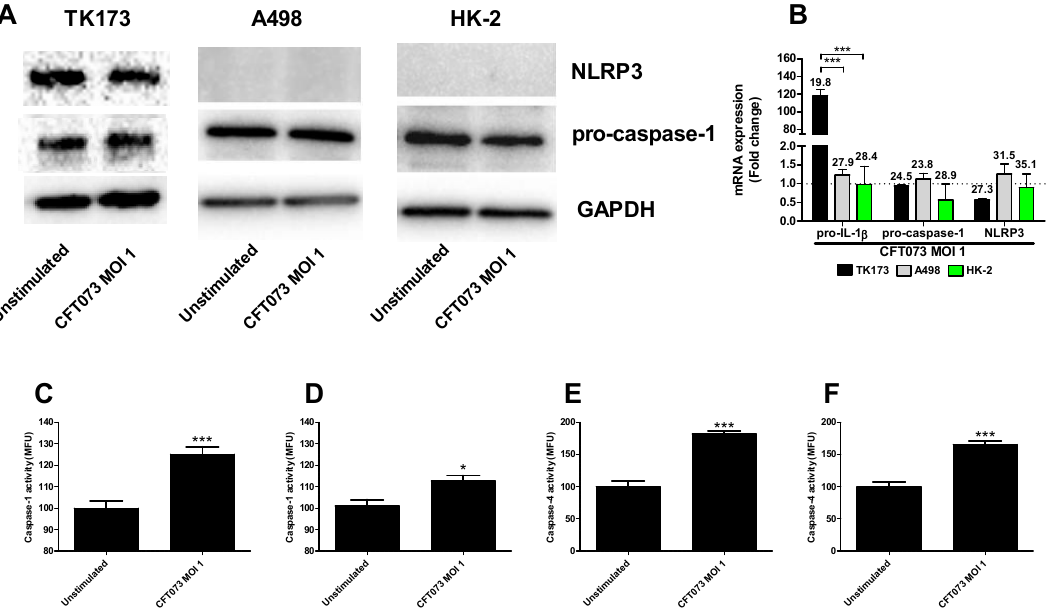
Figure 2. Caspase-1 and caspase-4 activity and pro-IL-1 β , pro-caspase-1 and NLRP3 expression. Renal fibroblasts ( A – F ) and renal epithelial cells ( A , B ) were infected with UPEC strain CFT073 at MOI 1 for 4 ( A – C , E ) and 6 h ( D , F ) followed by analysis of pro-caspase-1 and NLRP3 protein expression by Western blot ( A ), gene expression ( B ) and caspase-1 ( C , D ) and caspase-4 activity ( E , F ). Caspase-1/4 activity is presented as fold increase of mean fluorescence units (MFU) compared to unstimulated cells. GAPDH was used as a loading control for Western blots. The dotted line represents the unstimulated cells. Data are presented as mean ± SEM ( n = 3 independent experiments). Asterisks over bars denote statistical significance compared to respective unstimulated control, *** p < 0.001).